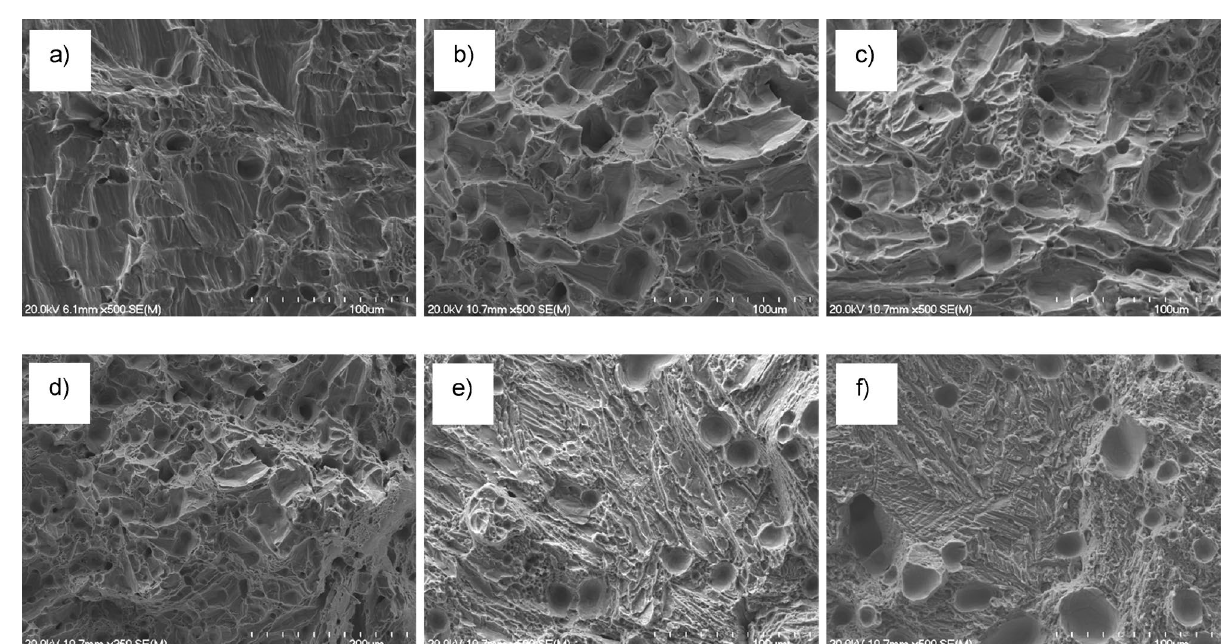
Figure 5. Representative results of the fractographic analysis for: ( a ) CP Ti, ( b ) Ti–0.5Cu–0.5Mn, ( c ) Ti–1Cu– 1Mn, ( d ) Ti–2Cu–2Mn, ( e ) Ti–3.5Cu–3.5Mn, and ( f ) Ti–5Cu–5Mn β eutectoid bearing functionalised Ti